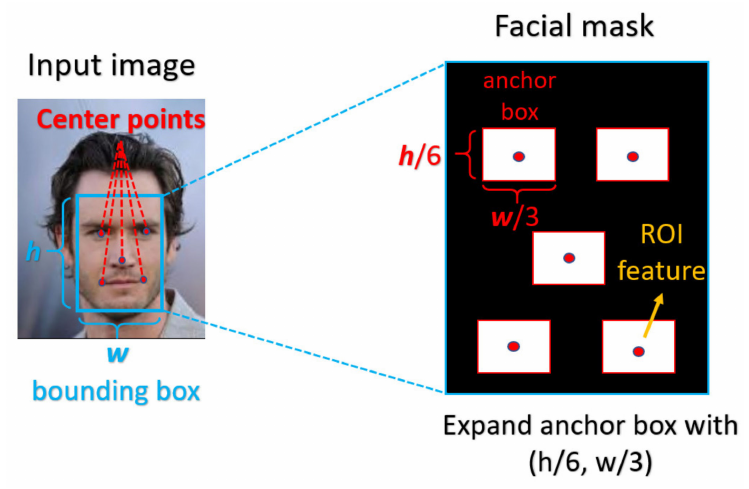
Figure 4. Face mask labeling for biometrics.